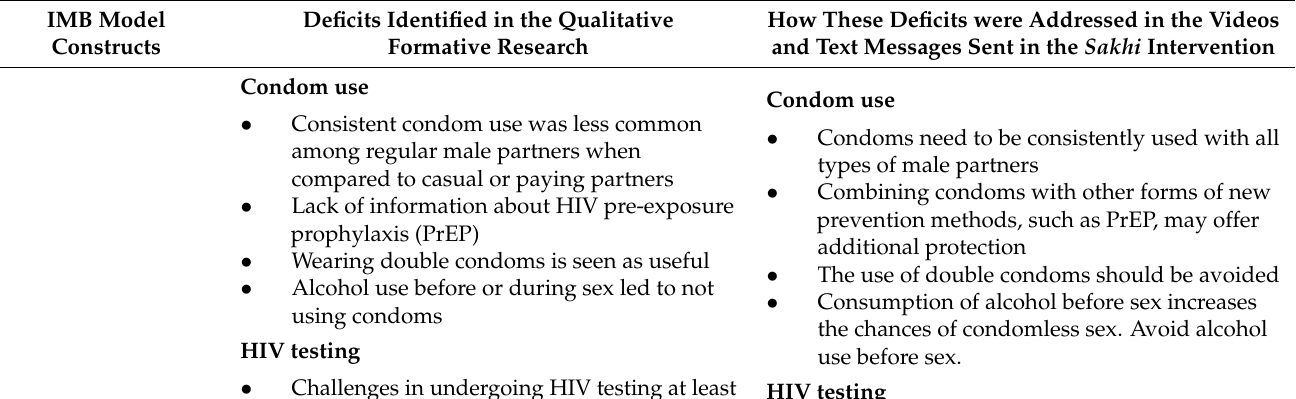
Table 1. Use of Information-Motivation-Behavioral Skills (IMB) model constructs in designing videos and messages for the smartphone-based Sakhi HIV prevention intervention for transgender